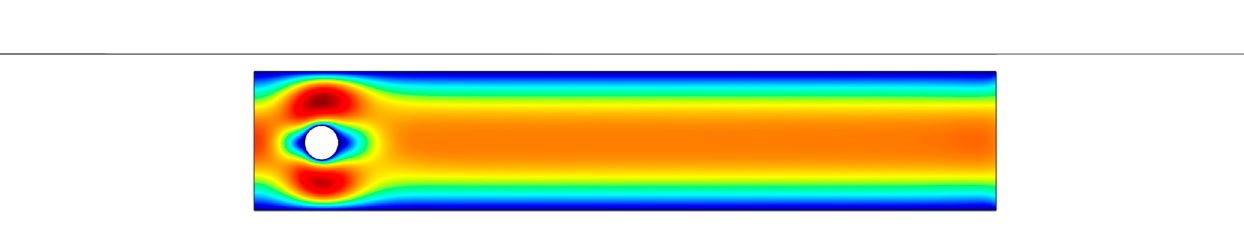
FIGURE 11 | Velocity pro fi le, at (cid:2) t (cid:1) 10 .